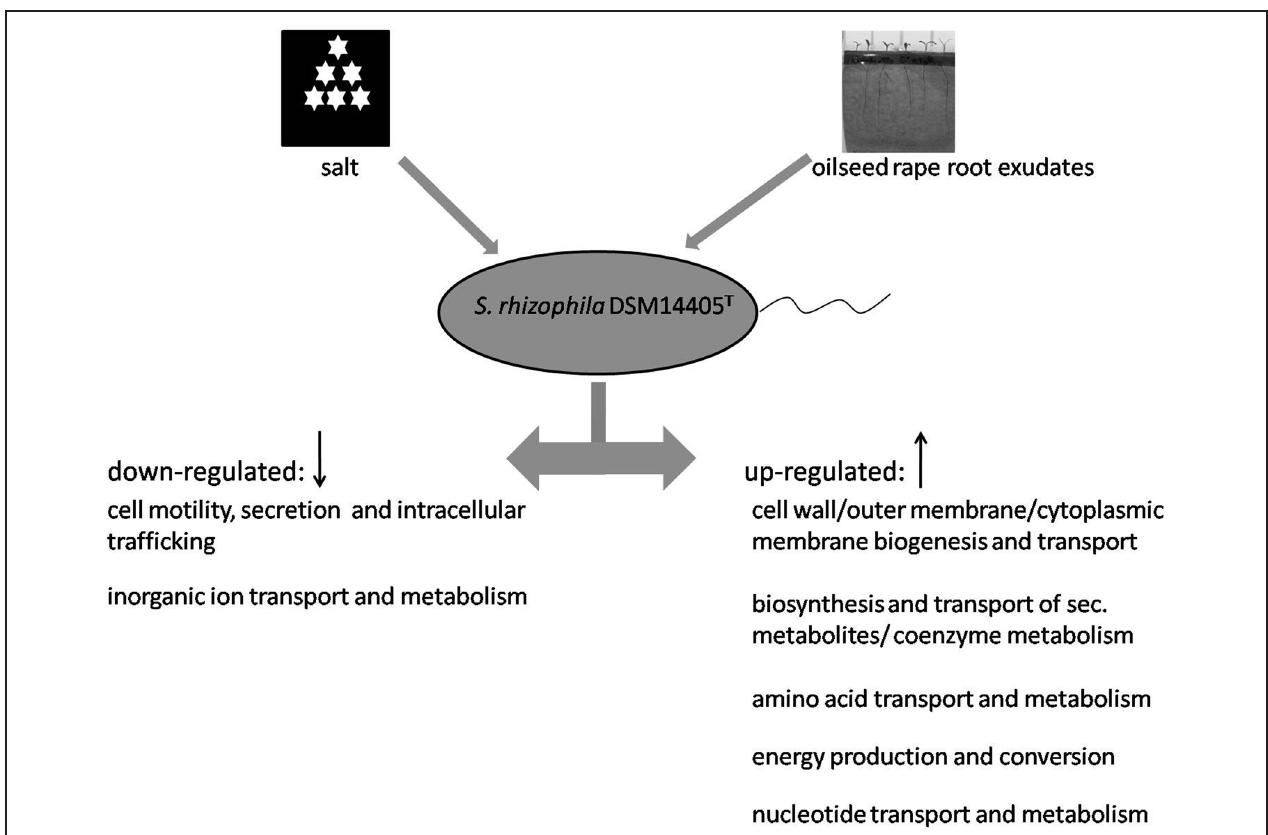
FIGURE 3 | Model showing the response of S. rhizophila DSM14405 T to osmotic stress: salt shock and root exudates. Functional gene groups shared in the response to oilseed rape root exudates and salt shock are presented. Several functional gene groups are up-regulated as a result of both oilseed rape root exudates and salt shock including those responsible